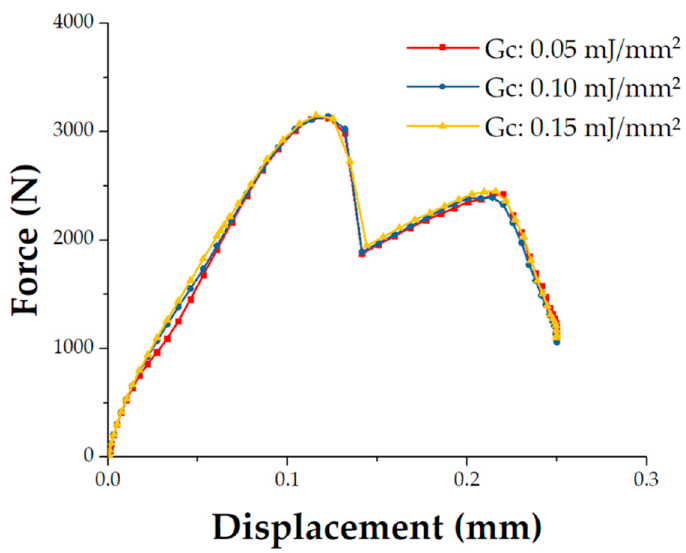
Figure 8. The load–displacement curves of the established numerical model with different critical energy release rate of the cohesive elements.